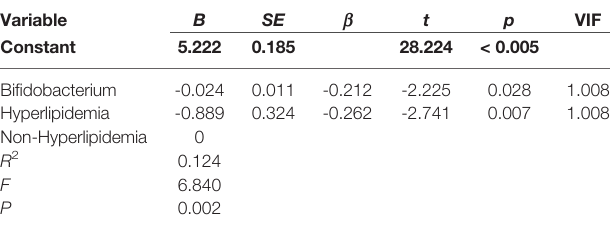
TABLE 3 | Linear regression analysis for Bi fi dobacterium predicting FLC l .